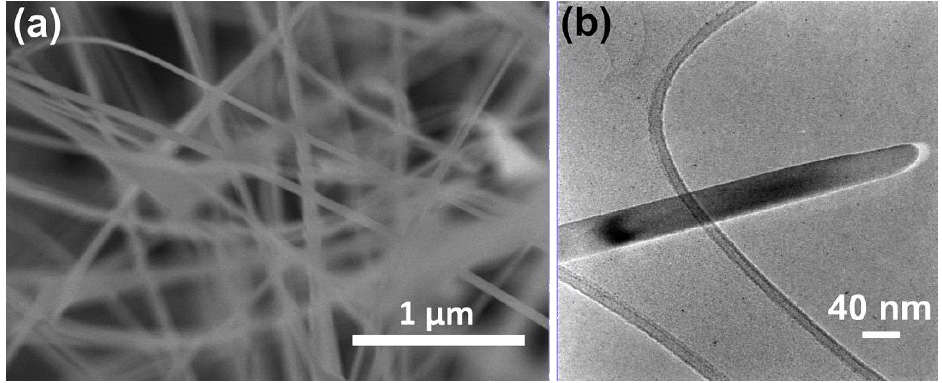
Figure 1. ( a ) SEM image of the SnO 2 nanowires forest; ( b ) TEM image of a nanowire tip.